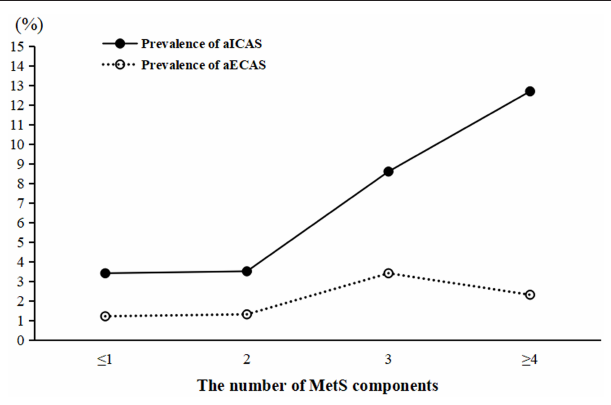
FIGURE 2 | Prevalence of aICAS and aECAS according to the number of MetS components. aICAS, asymptomatic intracranial arterial stenosis; aECAS, asymptomatic extracranial arterial stenosis; MetS, metabolic